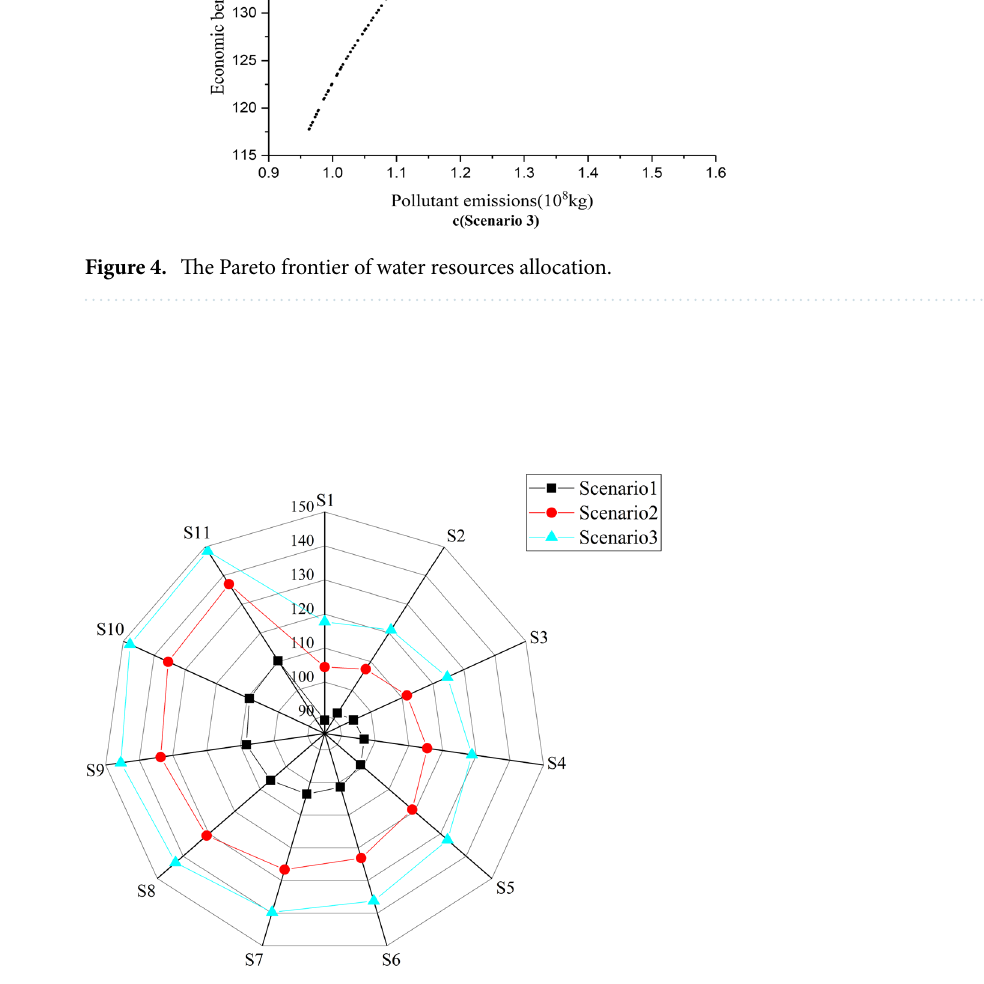
Figure 5. The economic benefits of WRA under three scenarios (10 10